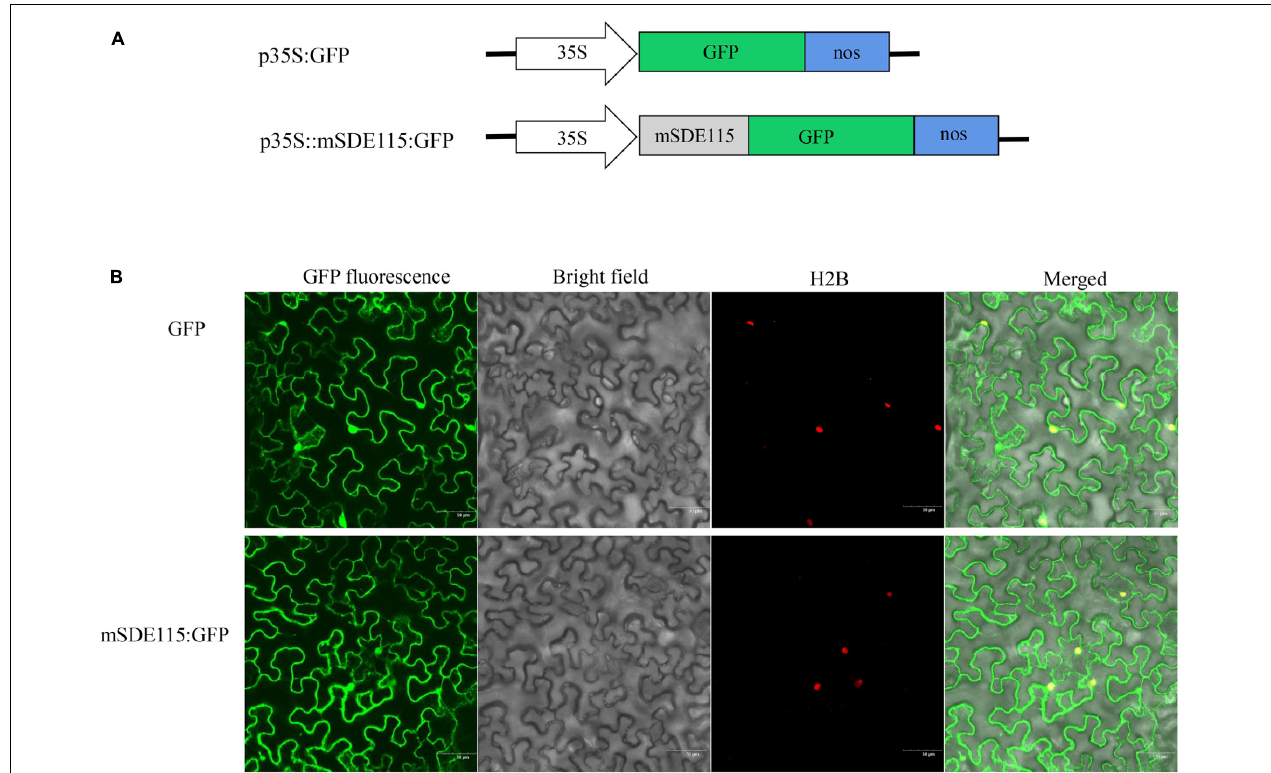
FIGURE 3 | Subcellular location of mSDE115 in tobacco epidermis cell. (A) Schematic diagram of the constructs used for agroinfiltration. A 35S, CaMV 35S promoter; NOS, the nopaline synthase terminator. (B) Subcellular localization of mSDE115:GFP fusion protein as observed by confocal microscopy. A histone 2B (H2B) fusion with the red fluorescent protein (RFP) was used as a marker for the nucleus (Martin et al., 2009).